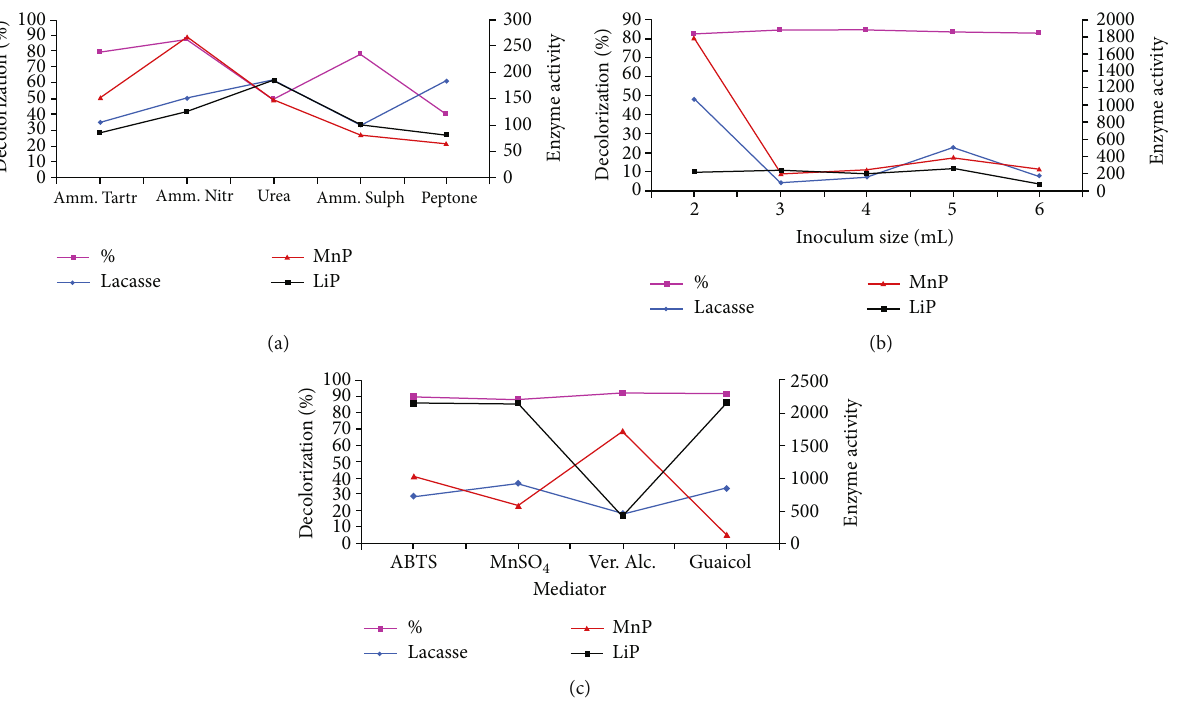
Figure 3: Removal of Drimaren Turquoise CL-B and enzyme activity of Schizophyllum commune at di ff erent (a) nitrogen source, (b) inoculum size, and (c)